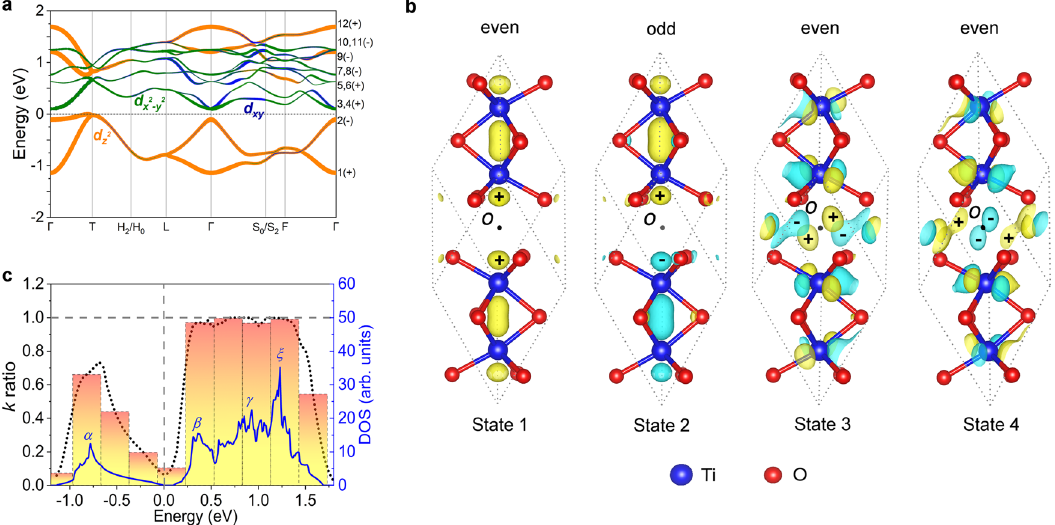
Fig. 4 | Origin of the ultra- fl at plasmon in α -Ti 2 O 3 . a Orbital-resolved band structureof α -Ti 2 O 3 .ThecontributionsfromtheTi3 d z 2 , d xy and3 d x 2 (cid:3) y 2 orbitalsare denotedbyorange,blueandgreencurves,respectively. b TheBlochelectronwave functionscorrespondingtothestate1,2,3,4atthe Γ point. O pointisthecenterof inversionsymmetry.Yellow(+)andblue( − )colorrepresentthesignoftherealpart